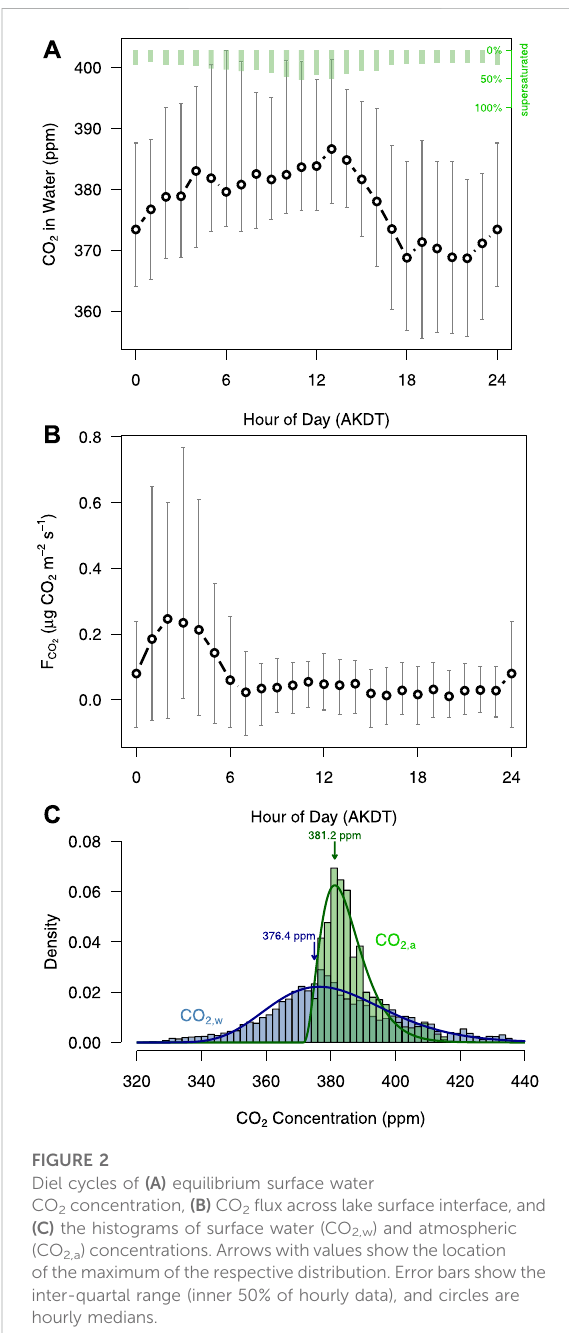
axes. Figure 4A shows CO 2 fl ux as the dominant variable in the second PCA axis. The two fi rst PCA axes in Figure 4A explain a total of 59.5% of the variance in the selected dataset (42.4 % and 17.1%). F CO increases as atmospheric CO 2 density (in mmol 2 m − 3 ) increases, but is almost unrelated to CO 2 mixing ratio